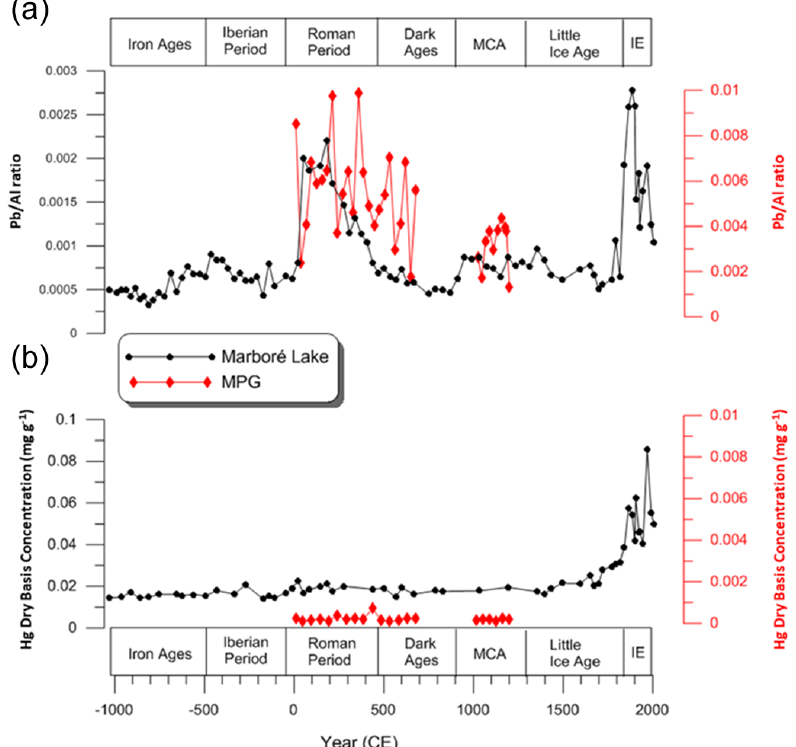
Figure 4. Comparison of Pb / Al ratio and Hg concentration of dry weight sediment in MPG samples with data obtained from Marboré Lake sediments (Corella et al., 2021). Note the differences in the vertical axis. Sample IDs from MPG are indicated in Table